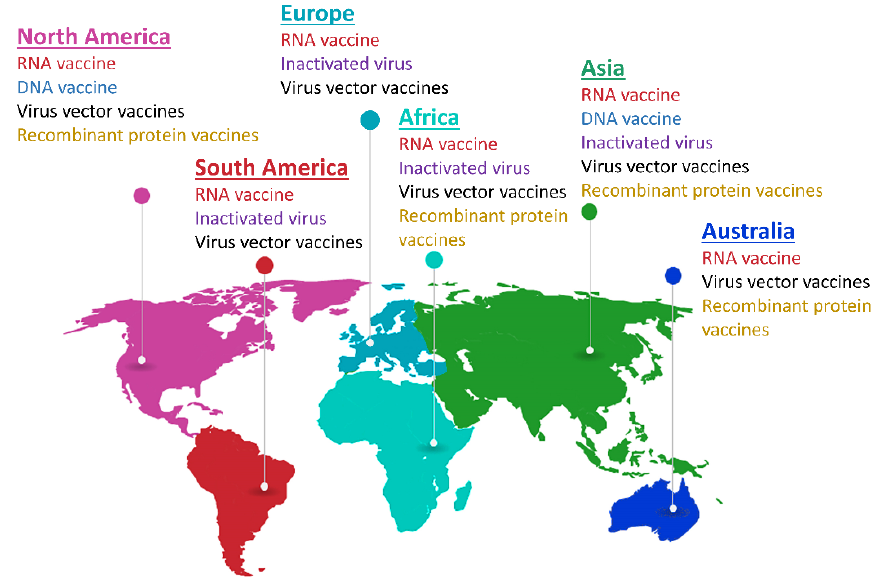
Figure 11. Global COVID-19 vaccines map. The use and development of COVID-19 vaccines is summarized in different continents.